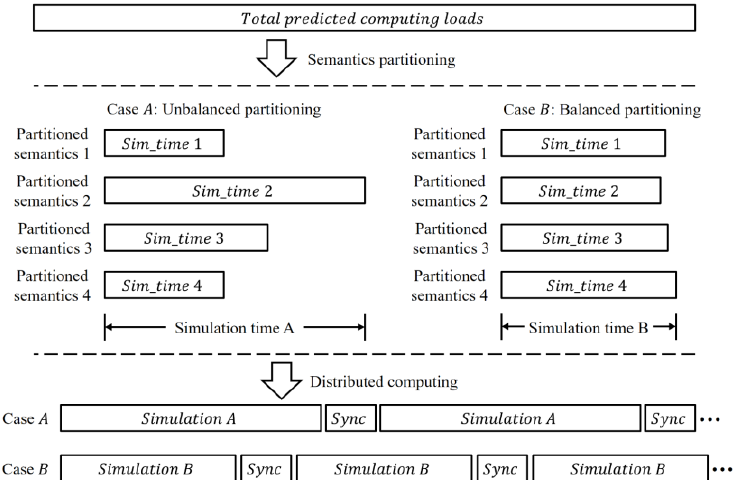
Figure 6. The simulation time comparison, in terms of balanced computing loads.